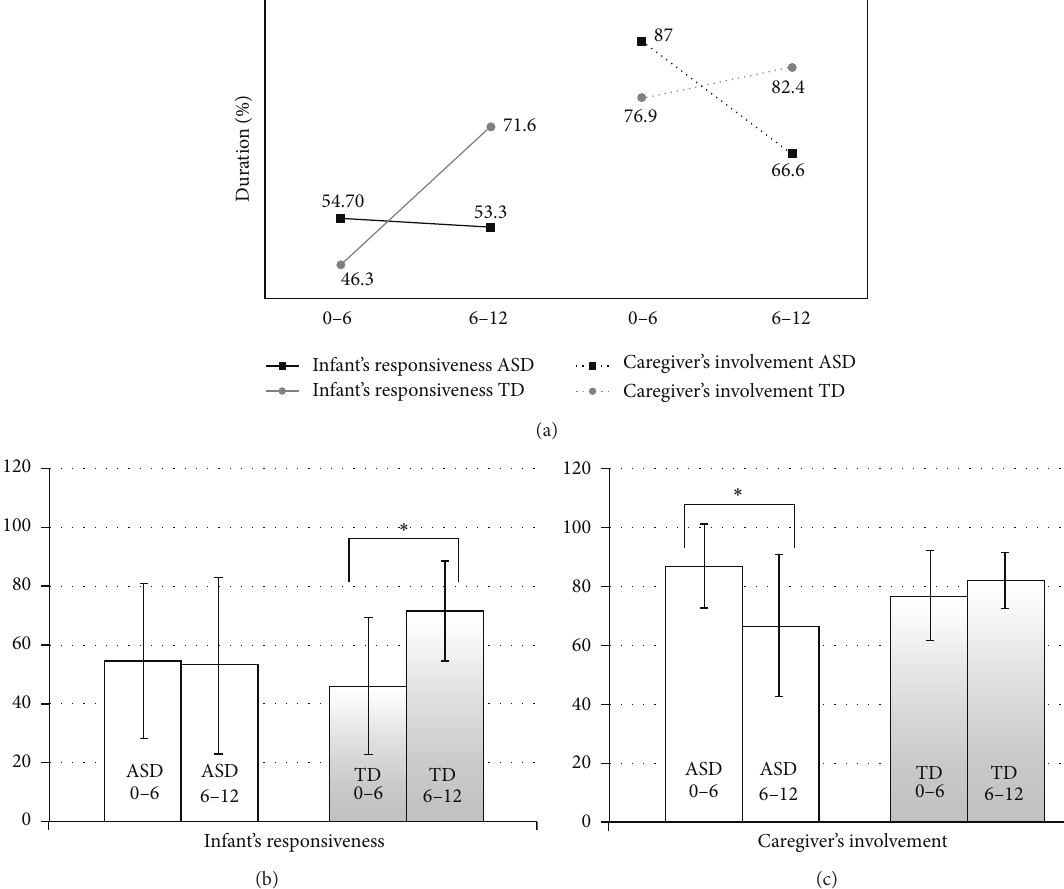
Figure 1: Trajectories of infant’s responsiveness versus caregiver’s involvement. (a) Trajectories (from T1 to T2) of infant’s responsiveness (b) and caregiver’s involvement (c). TD infants increase their responsiveness from T1 to T2 while in infants with ASD responsiveness remains stable. Caregivers of infants with ASD tend to decrease the time they spend in involvement. (b), (c) Means and standard deviations (error bars). ∗∗ 𝑃 ≤ 0.01 ; ∗ 𝑃 ≤ 0.05